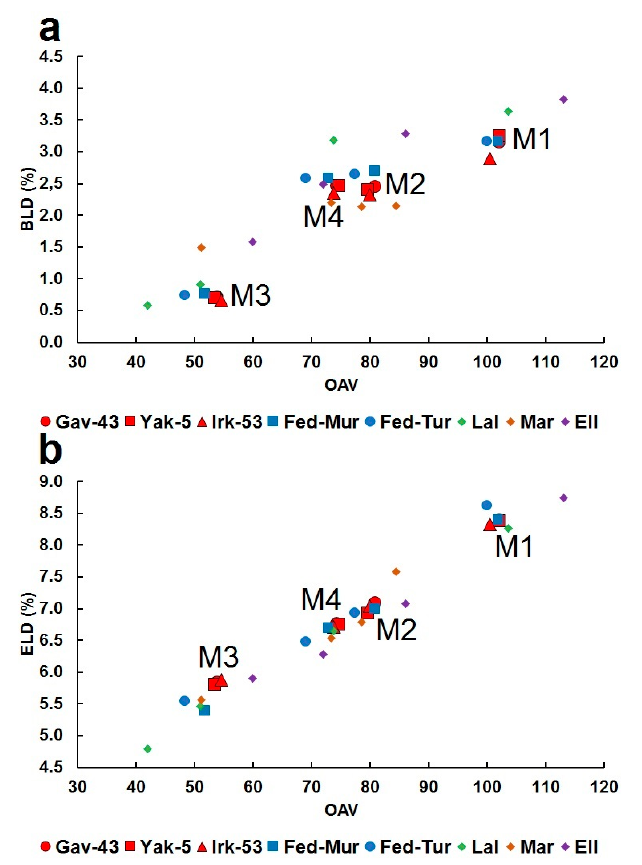
Figure 10. Relations between OAV (octahedral angle variance) and BLD (bond length distortion) ( a ) and ELD (edge length distortion) ( b ) for M1-M4 octahedra in the fedorite under study (sample Gav-43, Yak-5, Irk-53, Murun complex), fedorite from Murun (Fed-Mur) and Turiy complexes (Fed-Tur) [7], lalondeite (Lal) [39], martinite (Mar) [40] and ellingsenite (Ell) [41]. Data were taken from Table S13 of Supplementary Materials.